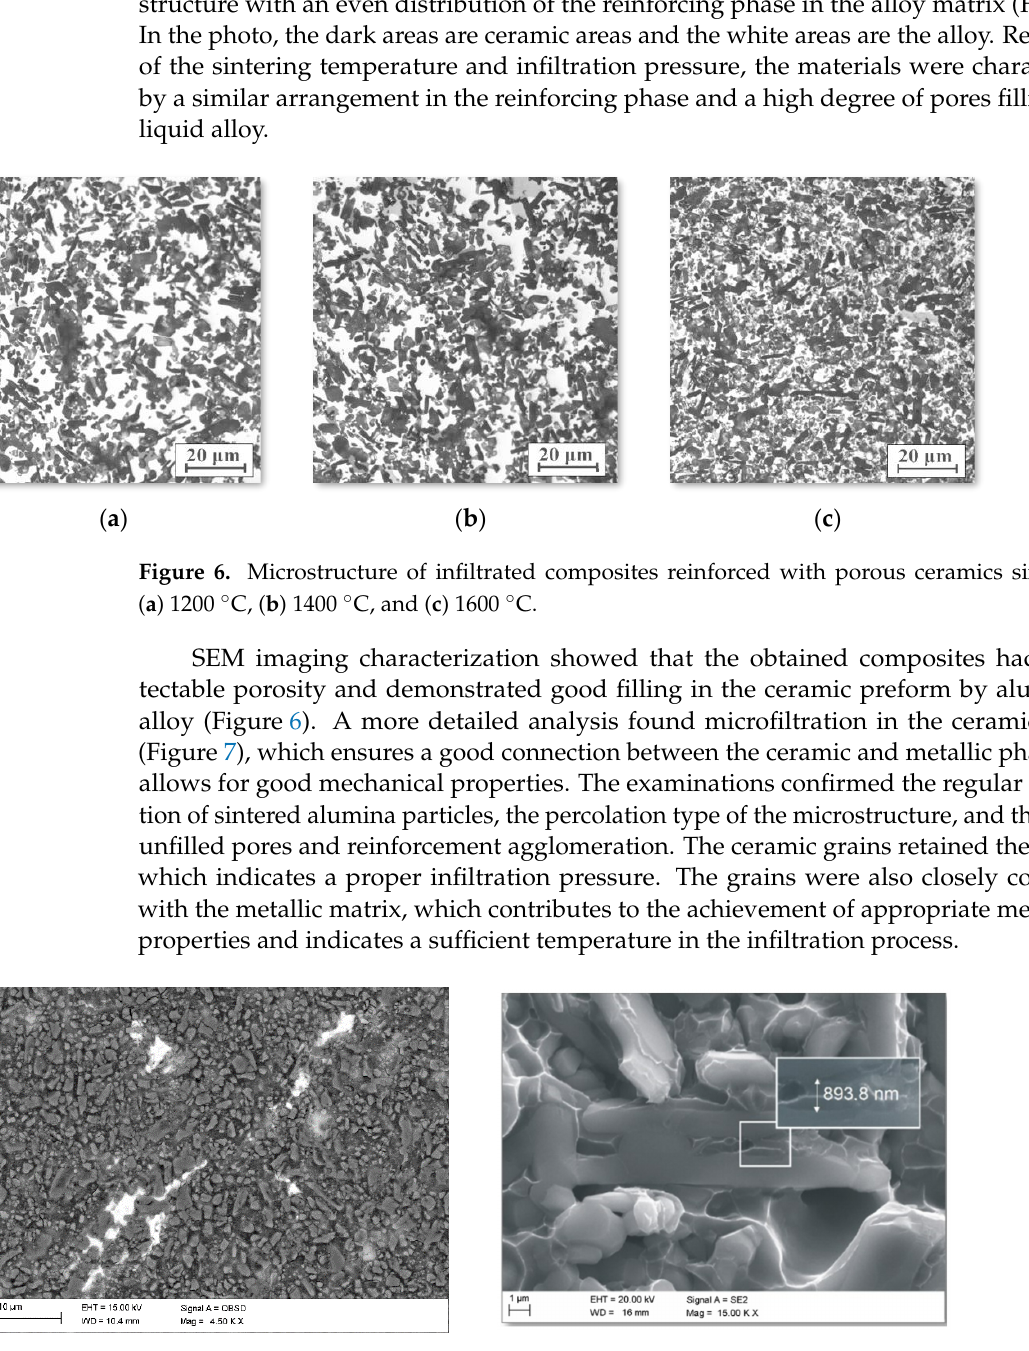
Figure 5. X-ray diffraction analysis results.